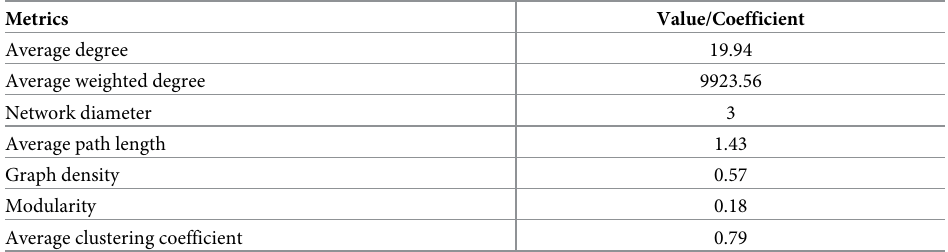
Table 5. The metrics related to the network between sectors based on common specializations.